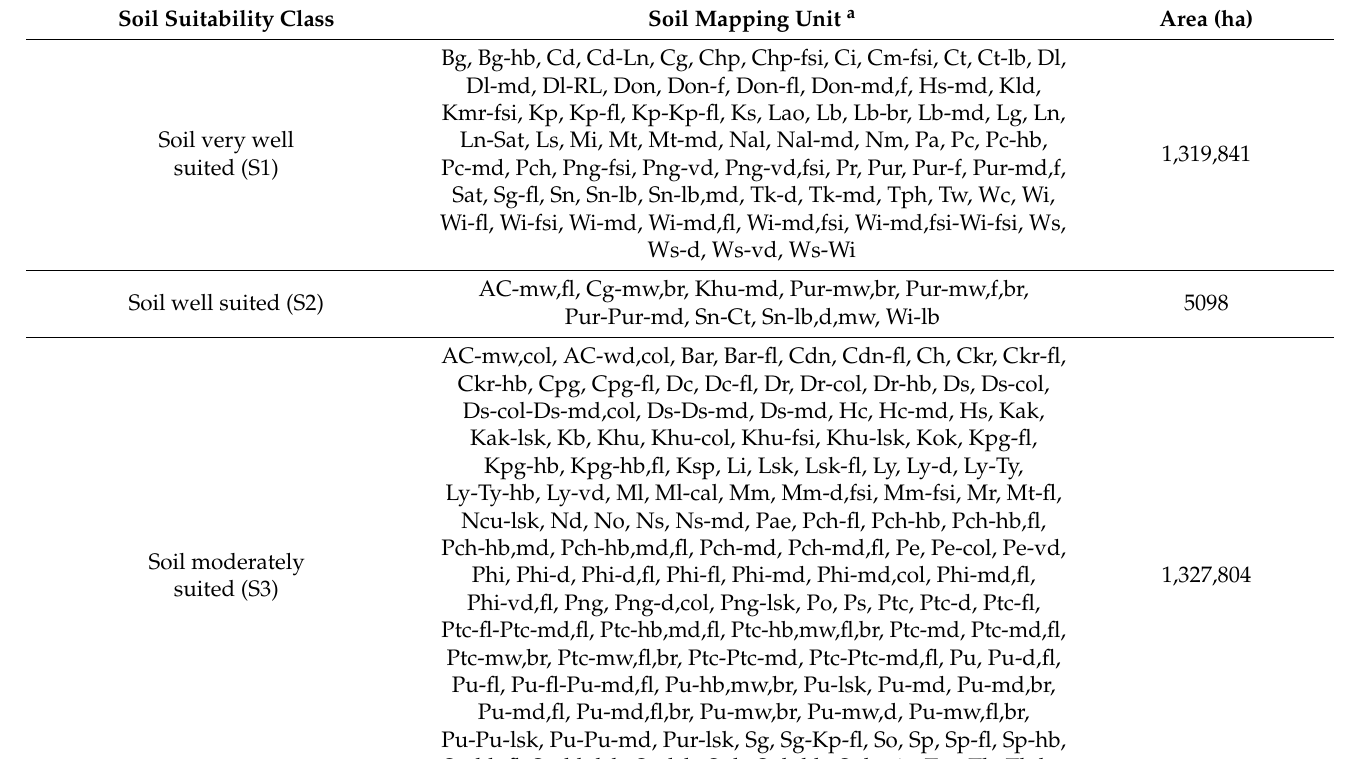
Table 3. Soil suitability class for mung bean cultivation in central Thailand based on soil properties and limitation